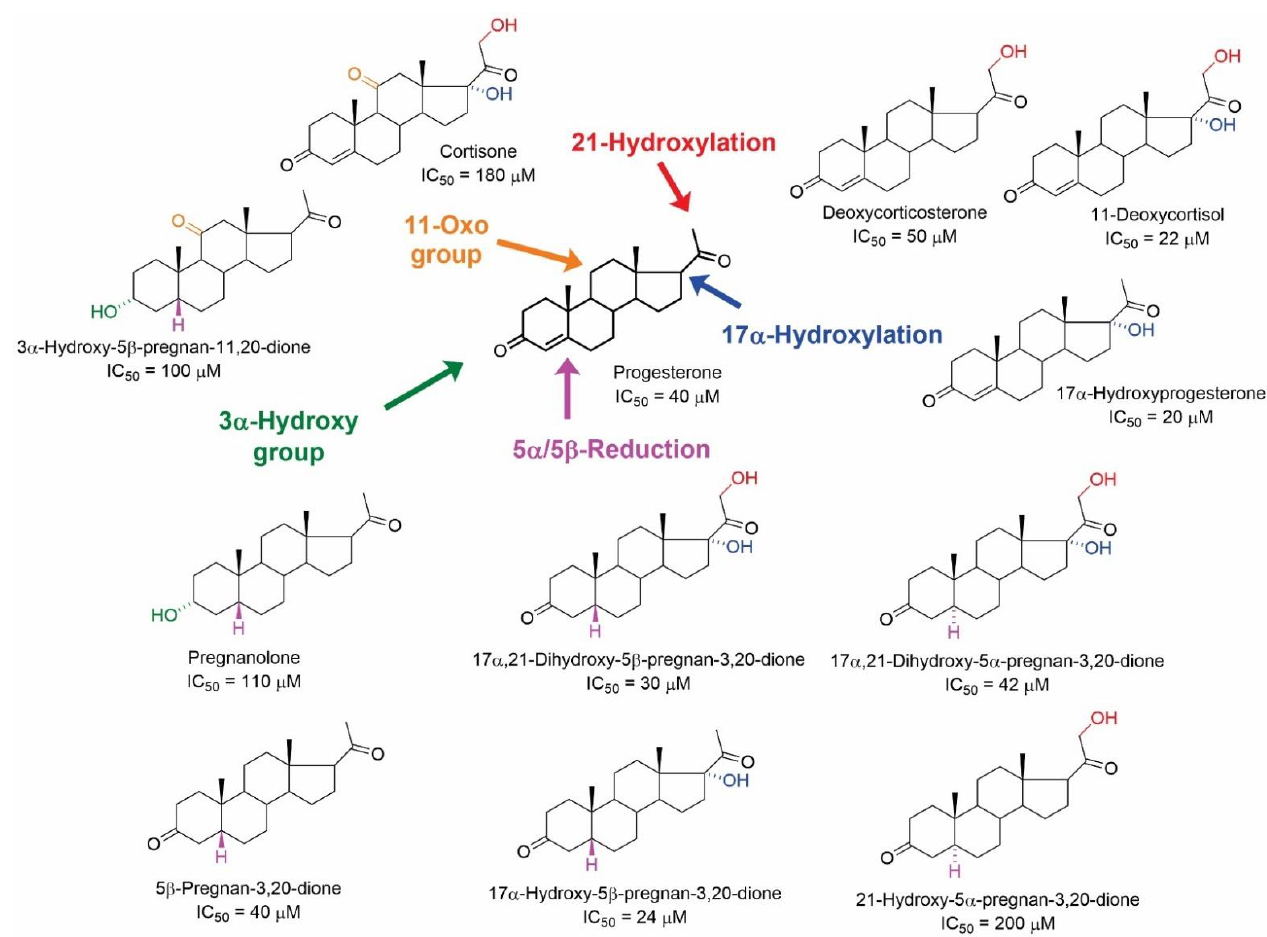
Figure 6. Structures of pregnane steroids with their IC 50 values in inhibiting the [ 3 H](-)QNB binding from the study of Klangkalya and Chan [44].